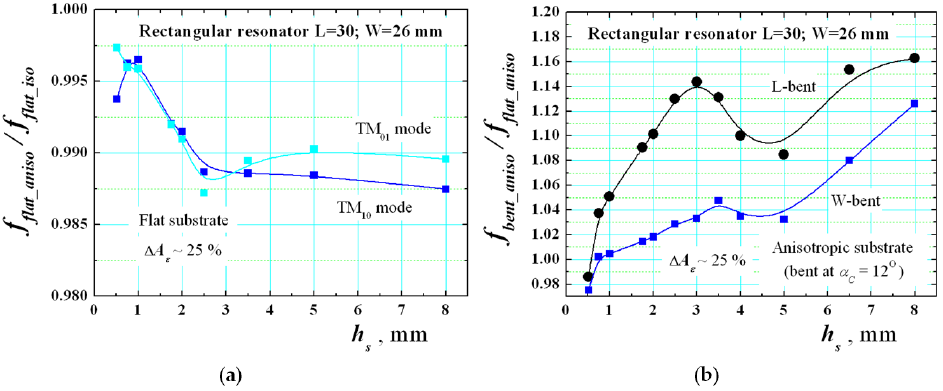
Figure 14. ( a ) Numerical dependencies of the ratio f flat_aniso / f flat_iso between the resonance frequencies of modes TM 10 and TM 01 for flat rectangular resonators on anisotropic and isotropic substrate versus the substrate thickness h s . ( b ) Numerical dependencies of the ratio f bent_aniso/ f flat_aniso of mode TM 10 for L-/W-bent and flat rectangular resonators on anisotropic substrates versus the substrate thickness h s .